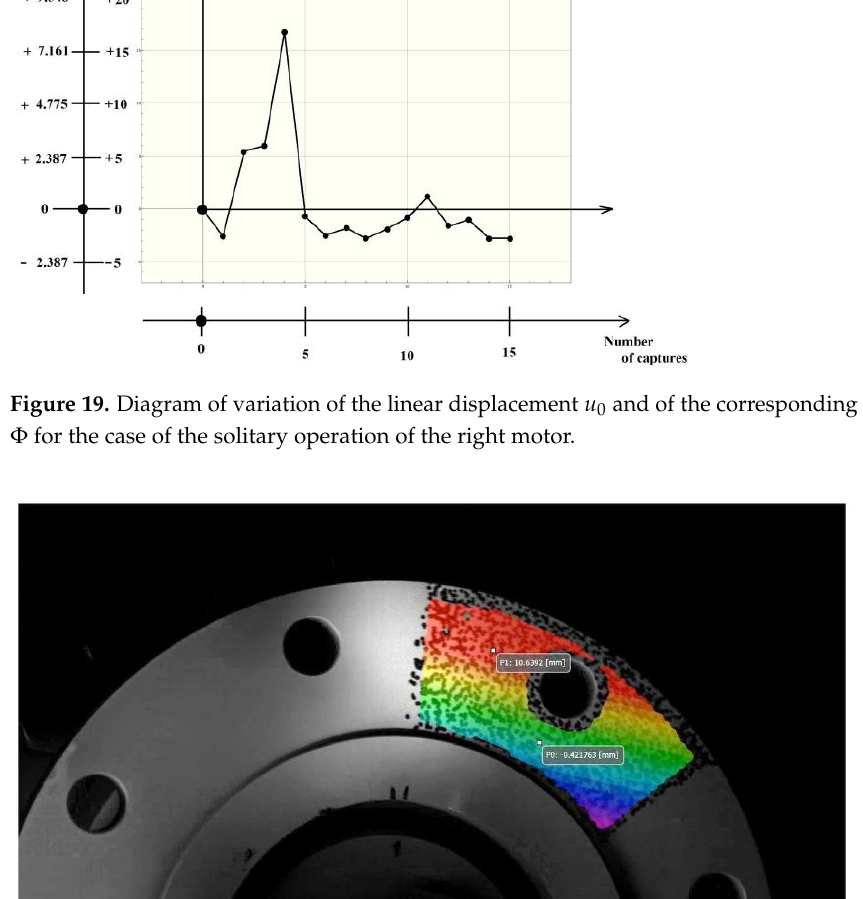
Figure 20. Flange, when both engines were running, together with the instantaneous values of the linear displacement u 0 of the representative point P 0 , respectively, u 1 of the point.